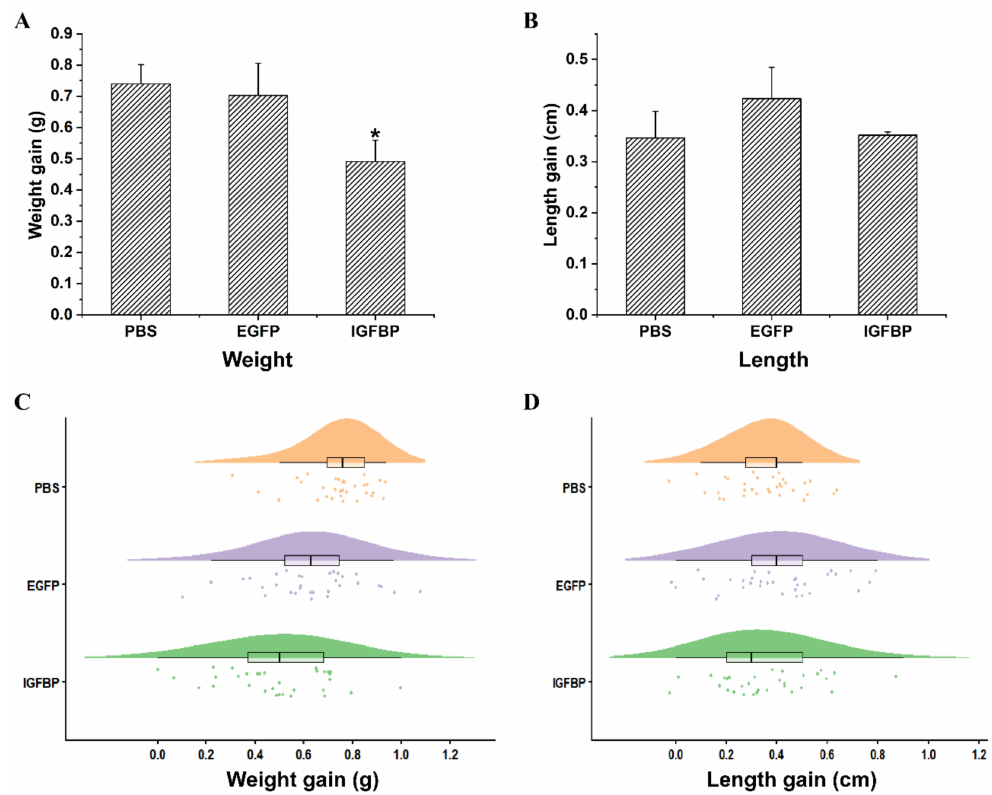
Figure 6. The growth characters after LvIGFBP1 RNAi in L. vannamei . The results were based on three independent biological replications and are shown as mean values ± SD. ( A ) The increase in body weight after LvIGFBP1 RNAi. ( B ) The increase in body length after LvIGFBP1 RNAi. ( C ) The raincloud figure reflected the increase in body weight after RNAi. ( D ) The raincloud figure reflected the increase in body length after RNAi. Significant differences of the gene expression levels between three treatments are shown as * p <